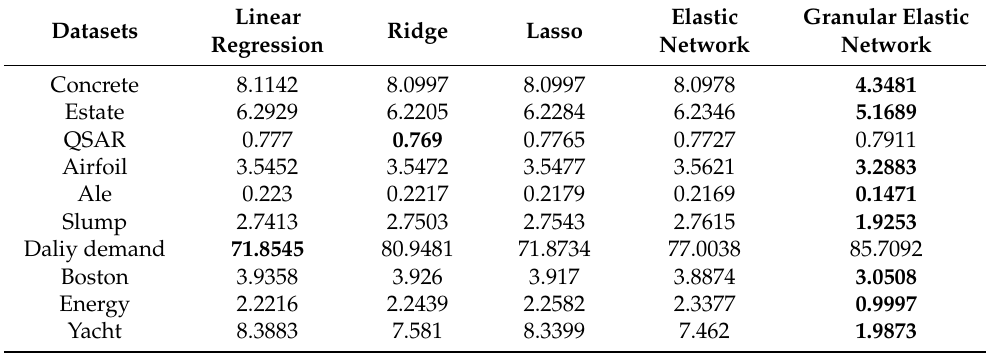
Table 2. The MAE results for granular elastic network regression and classical regression algorithms.